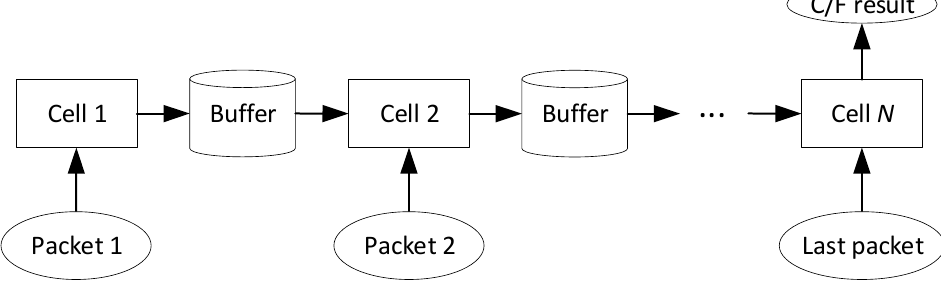
Figure 2. Proposed incremental classification for a session using LSTM.